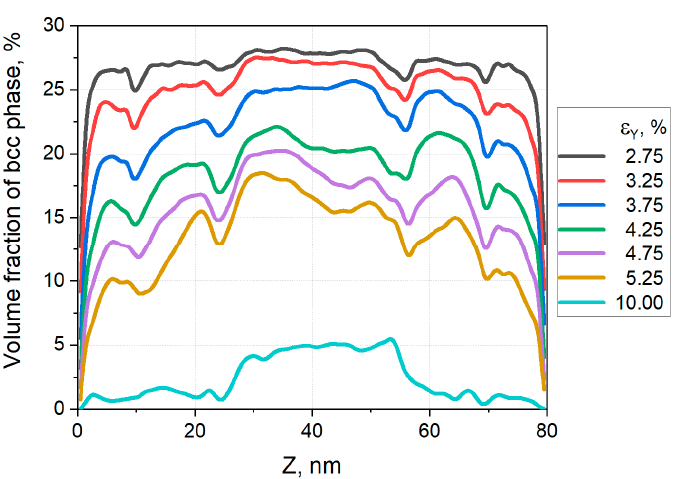
Figure 7. Z-axial distribution of the volume fraction of the bcc phase for different tensile strains of the bcc30_L1 sample.